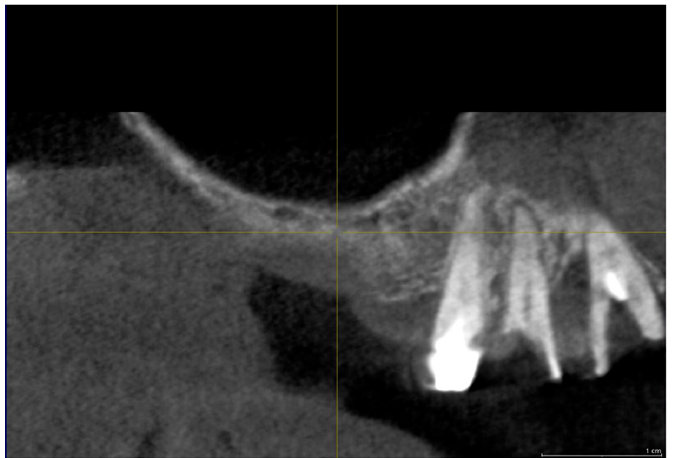
Figure 5. Group II. CBCT image before sinus lifting showing reduced bone height in the sinus area with a residual alveolar ridge height between 1 and 3 mm.